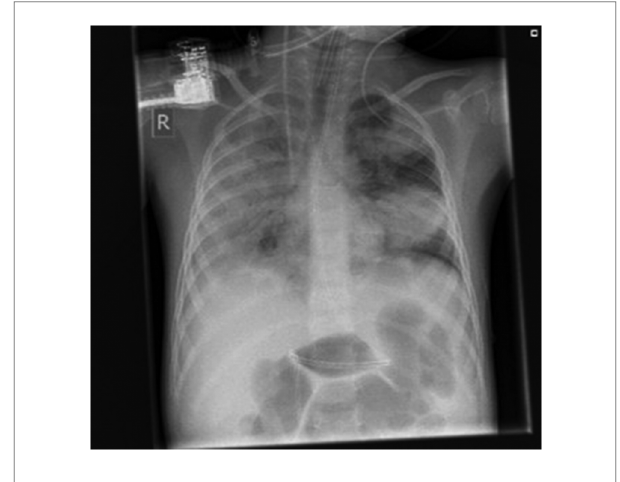
FIGURE 1 X ray case 1, twelve hours after